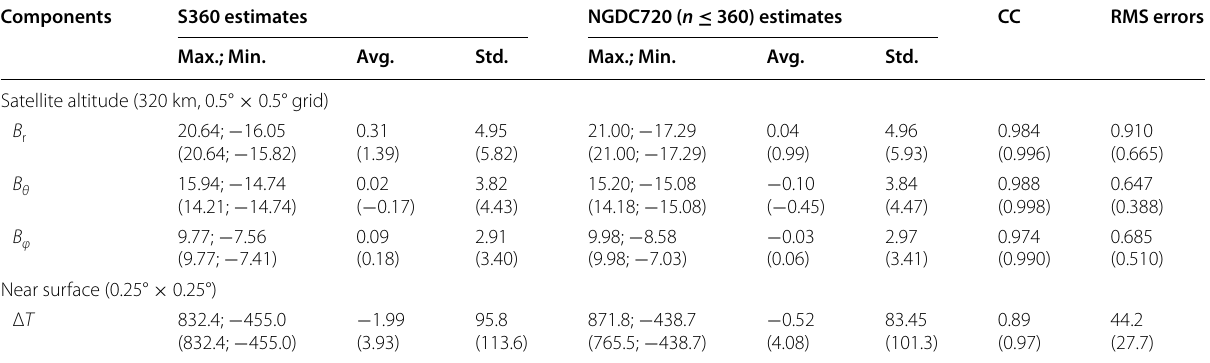
See Table 1 for the abbreviations of the listed statistics. The numbers in parentheses are for the Australian mainland and Tasmania